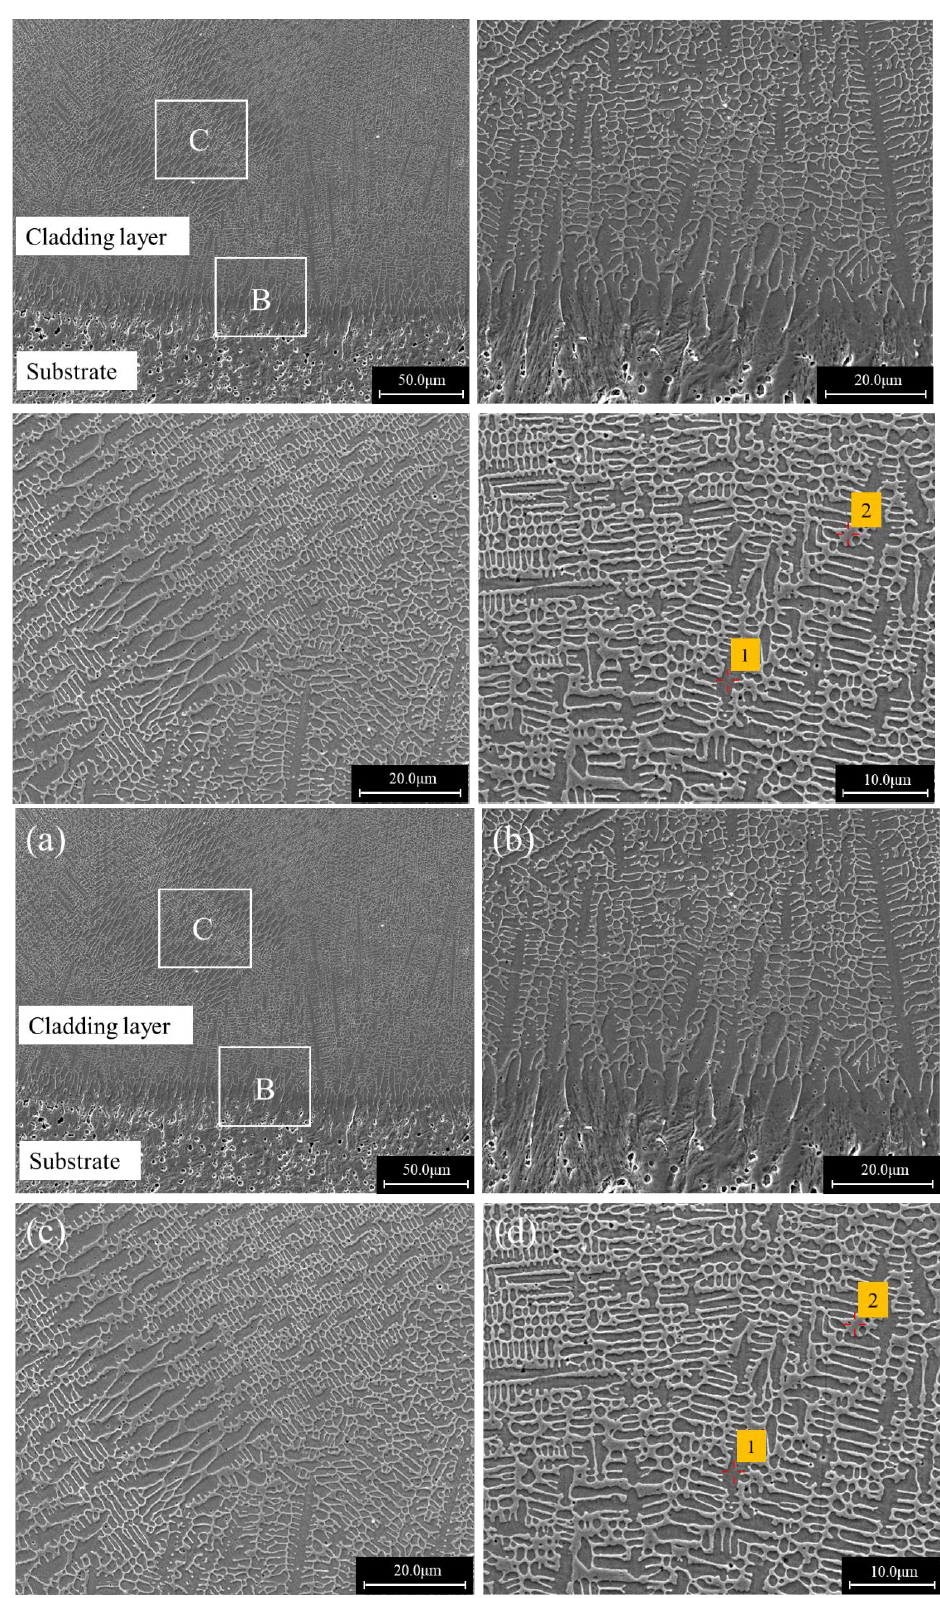
Figure 5. Cross sectional morphologies of a single-bead cladded specimen produced at the scanning speed of 10 mm / s: ( a ) Overall view; ( b ) an enlarged view of region B in ( a ); ( c ) an enlarged view of region C in ( a ); ( d ) an enlarged view of ( c